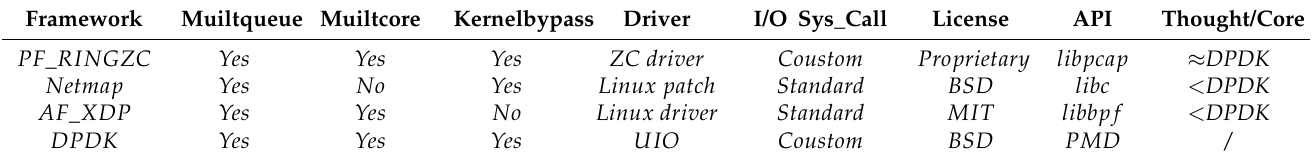
Table 1. Comparison of Four Zero-copy DMA